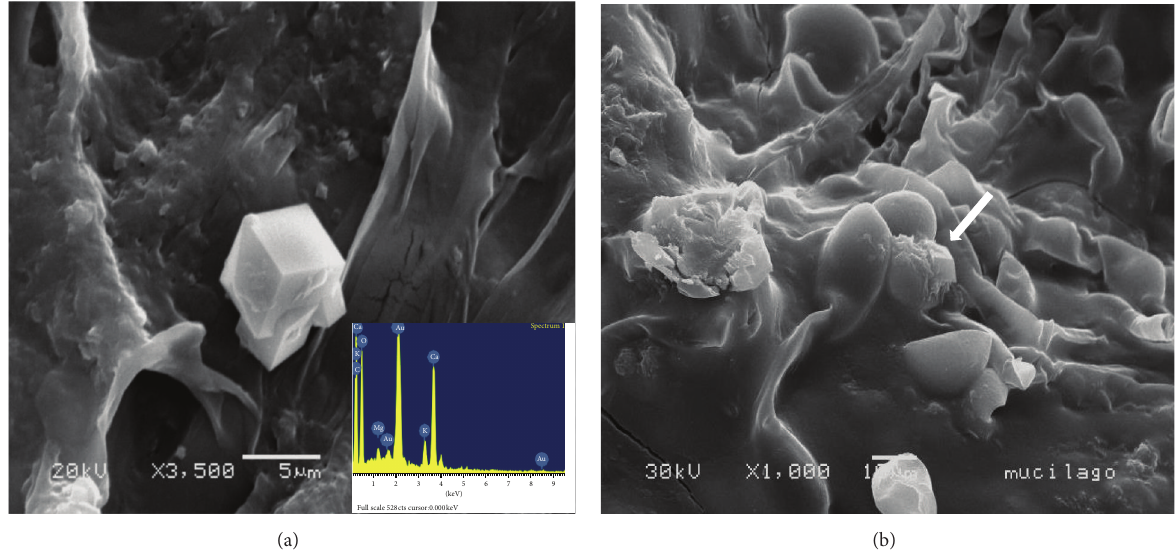
Figure 2: SEM images and EDS analysis of soluble dietary fiber extracted from O. ficus indica , (a) prismatic crystal in soluble dietary fiber with elemental analysis by EDS and (b) prismatic crystal emerging from a globular structure located in soluble dietary